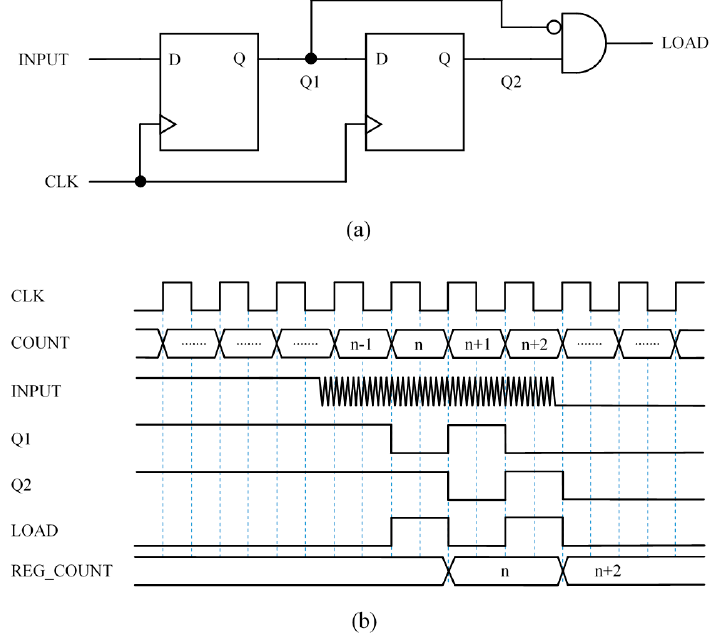
Figure 5. Capture Module 1—Synchronous circuit to signal the input fall edge with a pulse: ( a ) circuit and ( b ) example chronogram.